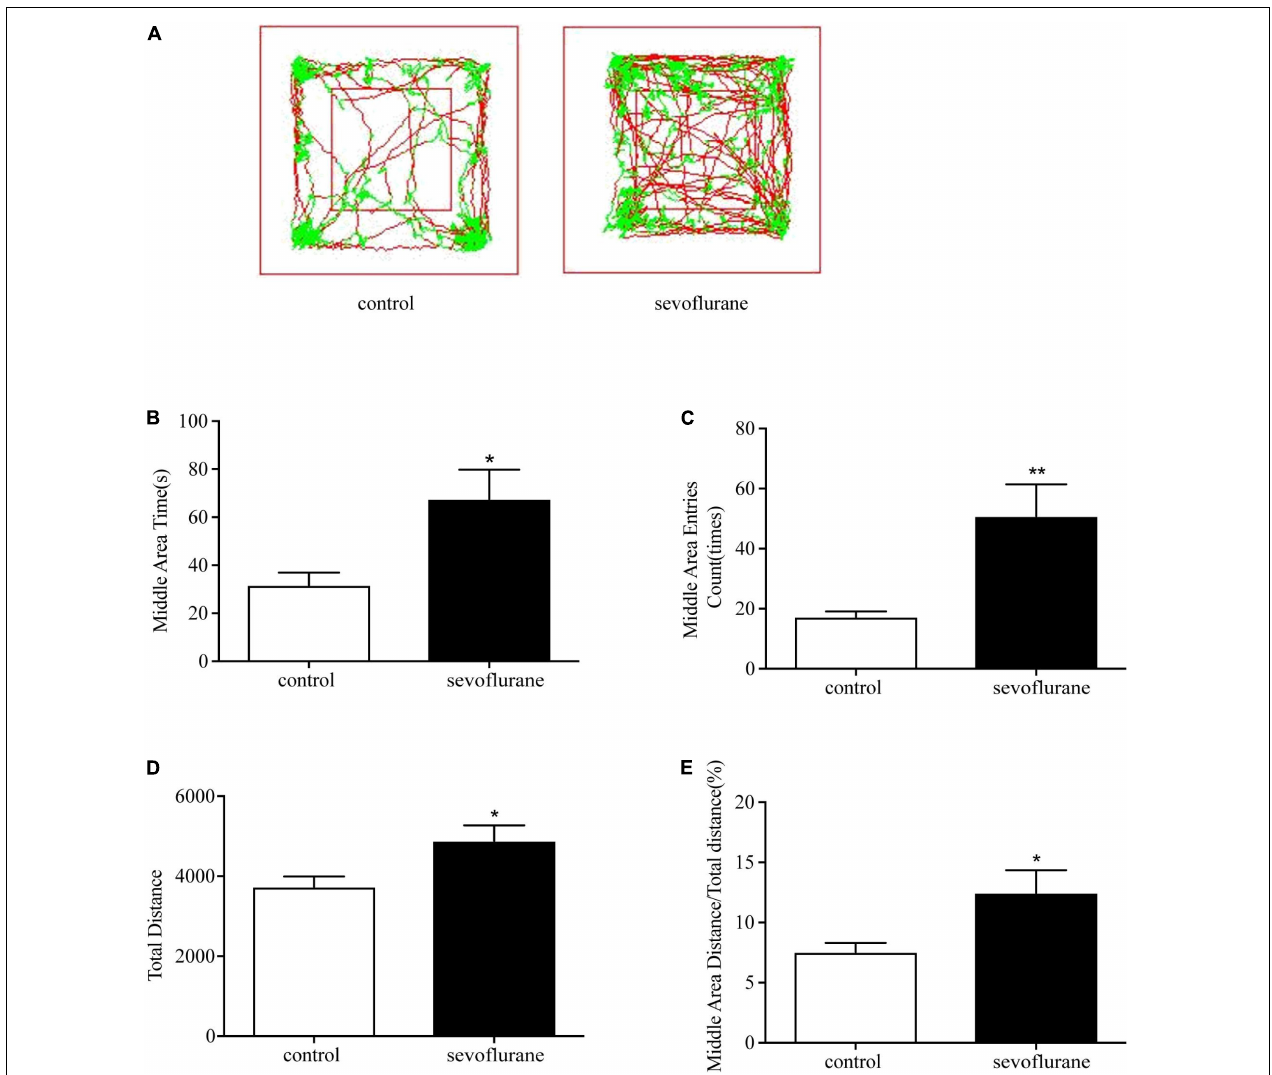
FIGURE 1 | Sevoflurane exposure changed movements in the open field test. Seven-day-old pups were exposed to 3% sevoflurane for 4 h and then allowed to grow up to 2 months. They were then subjected to the open field test. (A) The representative movement traces showing the locations of control and sevoflurane mice in the open field test. (B) The traveling total distance; (C) the crossing times in the central area; (D) the time spent in the central area; (E) and the traveling distance in the central area. Data are presented as mean ± SEM ( n = 11). * P < 0.05; ** P < 0.01. sevo,